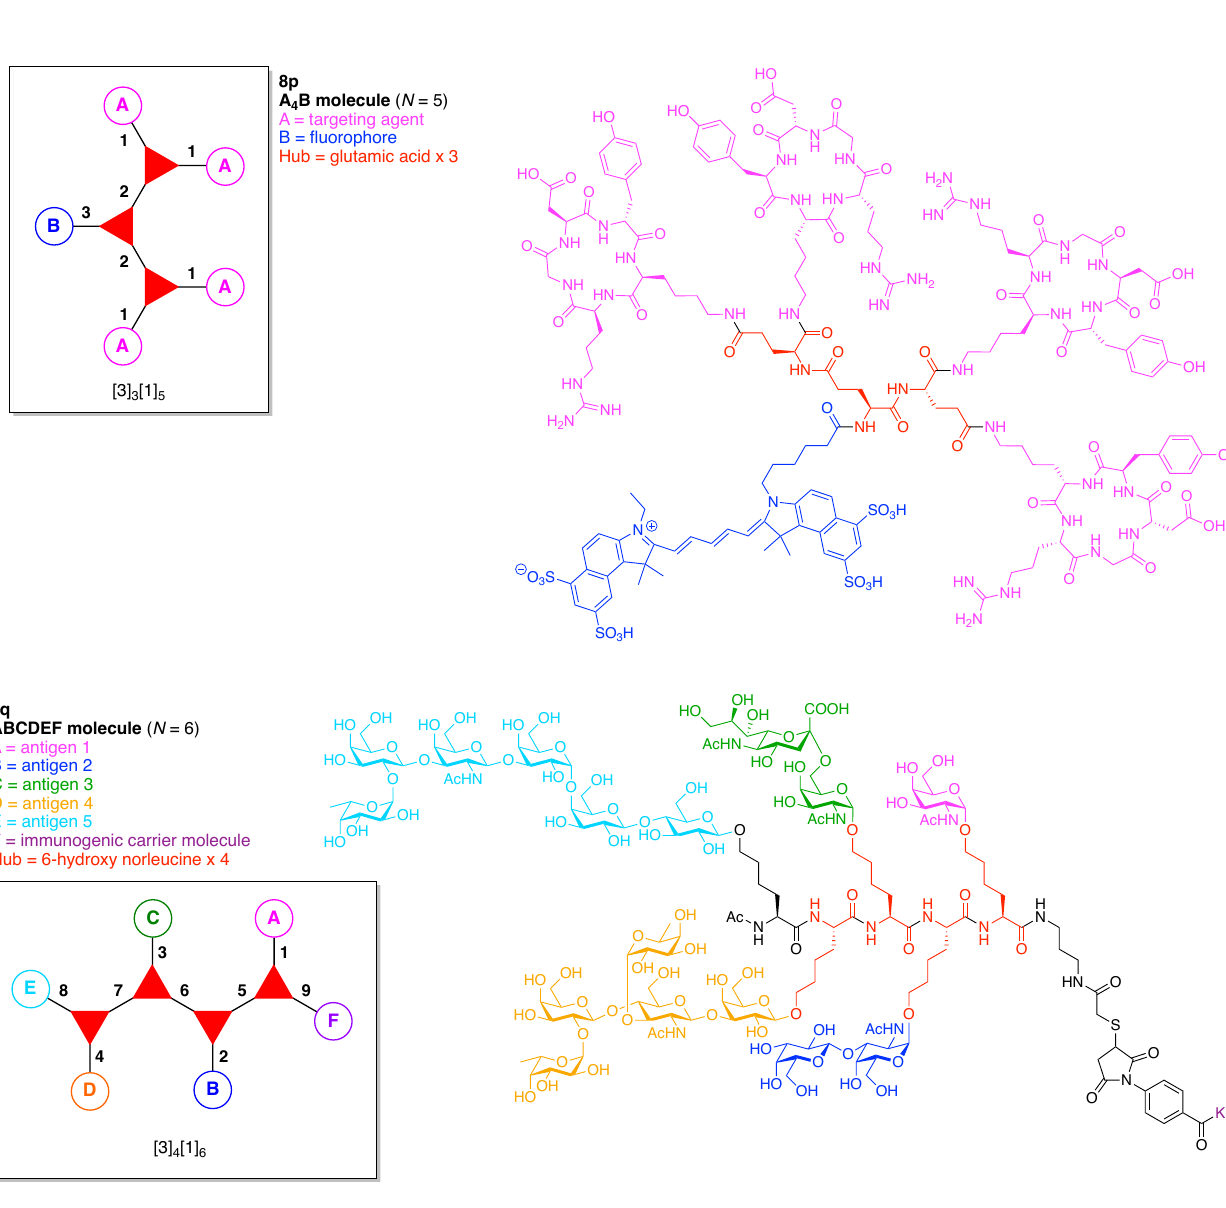
Figure 31. Two examples each with several amino acid hubs.